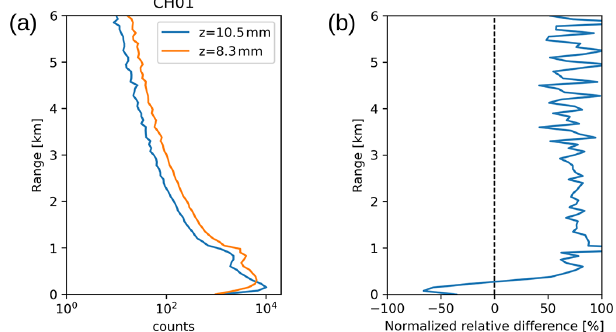
Figure 15. Background subtracted counts (a) and relative difference between the normalized signal CH01 / CH02 profiles (b) in the se- lected position ( x = 9 . 45mm y = 10 . 55mm z = 8 . 30mm) and the starting one ( x = 9 . 40mm y = 10 . 50mm z = 10 .